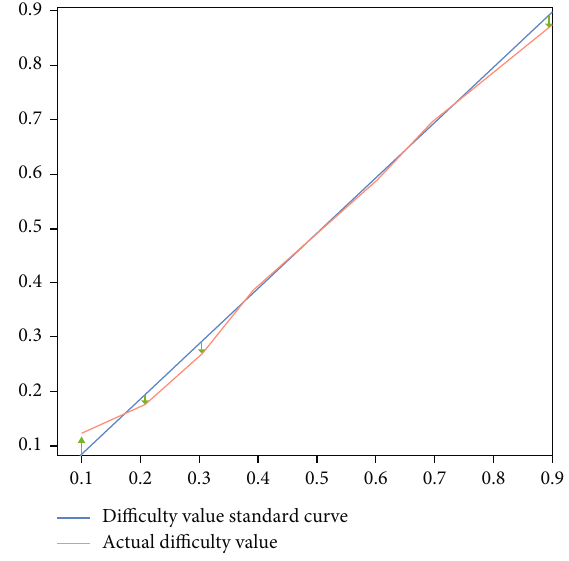
Figure 6: Comparison results of actual recommended exercise di ffi culty and theoretical di ffi culty index values of exercise recommendation model.